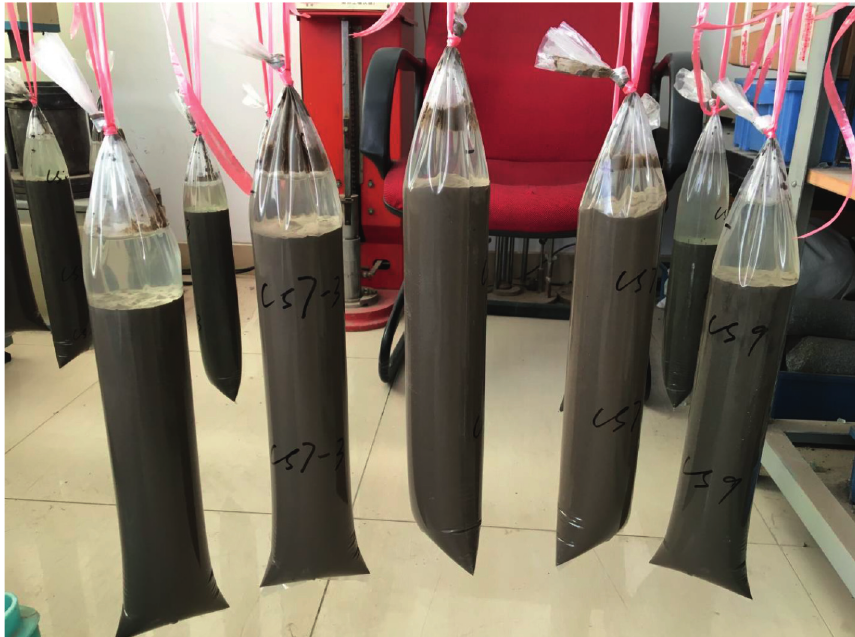
Figure 3: Sampling by the hanging bag method. Table 3: Test results of cement soil at the enlarged base.